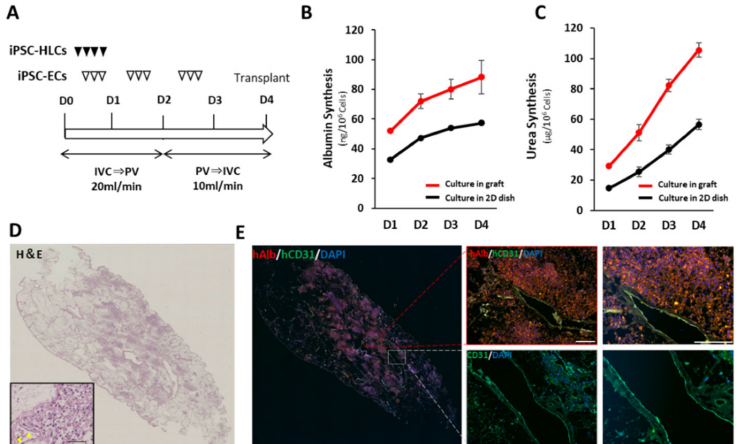
Figure 3. Recellularization of scaffold with hiPSC-HLCs and hiPSC-ECs. ( A ) Protocol for recel- lularization with hiPSC-HLCs and hiPSC-ECs. ( B ) Accumulative value of ALB secreted from the hiPSC-HLCs into the supernatants of culture medium collected from in-graft and on-dish cultures (mean ± SD, n = 3). Values were normalized based on the number of cells used in the culture. ( C ) Accumulative value of urea secreted from iPSC-HLCs in the supernatants of culture medium collected from in-graft and on-dish cultures (mean ± SD, n = 3). Values were normalized based on the number of cells used in the culture. ( D ) H&E staining of the recellularized scaffolds sections. A magnified view is shown in the lower left frame. Scale bar = 100 µ m. Yellow arrow heads indicate the engrafted hiPSC-ECs on the vessel wall. ( E ) Co-immunostaining images of human ALB and human CD31 counterstained with DAPI. Scale bar = 100 µ